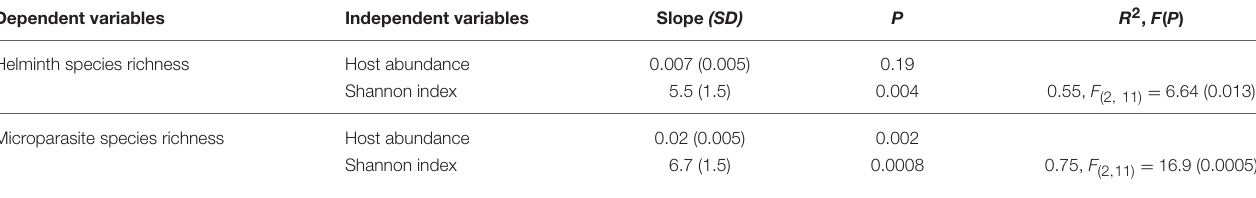
TABLE 2 | Best model explaining helminth species richness and microparasite species richness in Southeast Asian rodents using independent contrasts (initial model with host abundance, host range (number of localities), habitat centrality and Shannon index) using the AIC criteria (with SD =standard deviation of the